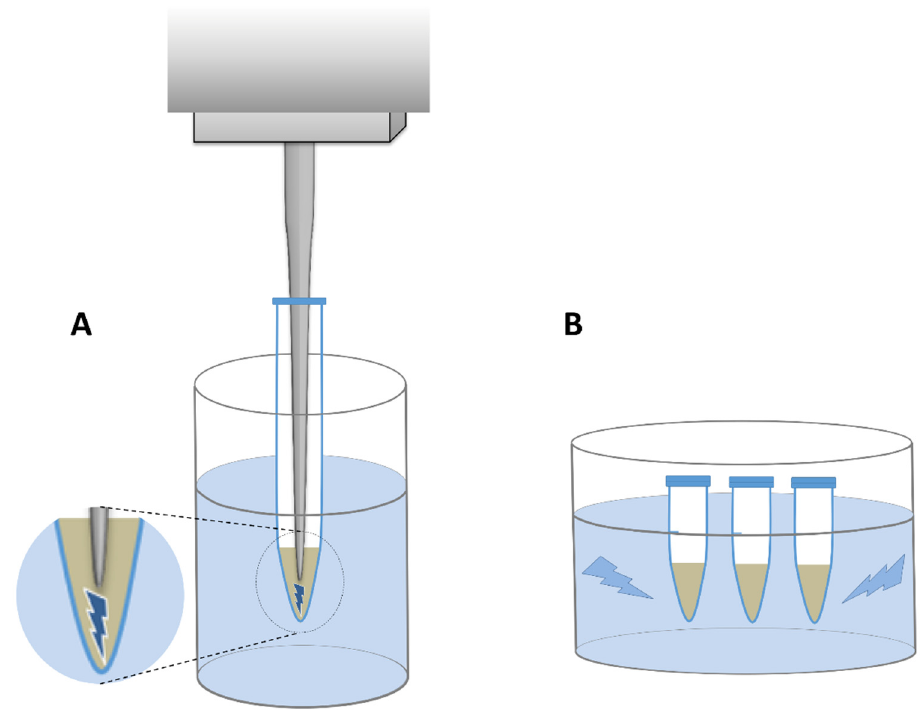
Figure 3. Schematic representation of two sonicator types. ( A )—probe sonicator, ( B )—bath sonicator. The area where the ultrasounds generated by probe are released was shown in magnification. Table 2. The mechanical lysis workflow.